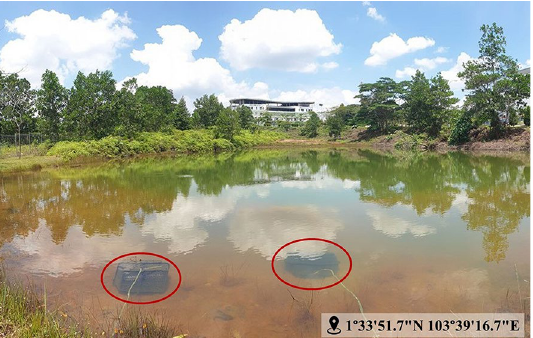
Figure 1. The actual field site of this research located within the Universiti Teknologi Malaysia Johor Bahru campus. The red circles marked the placement of the plastic baskets containing the non-porous substrates bearing